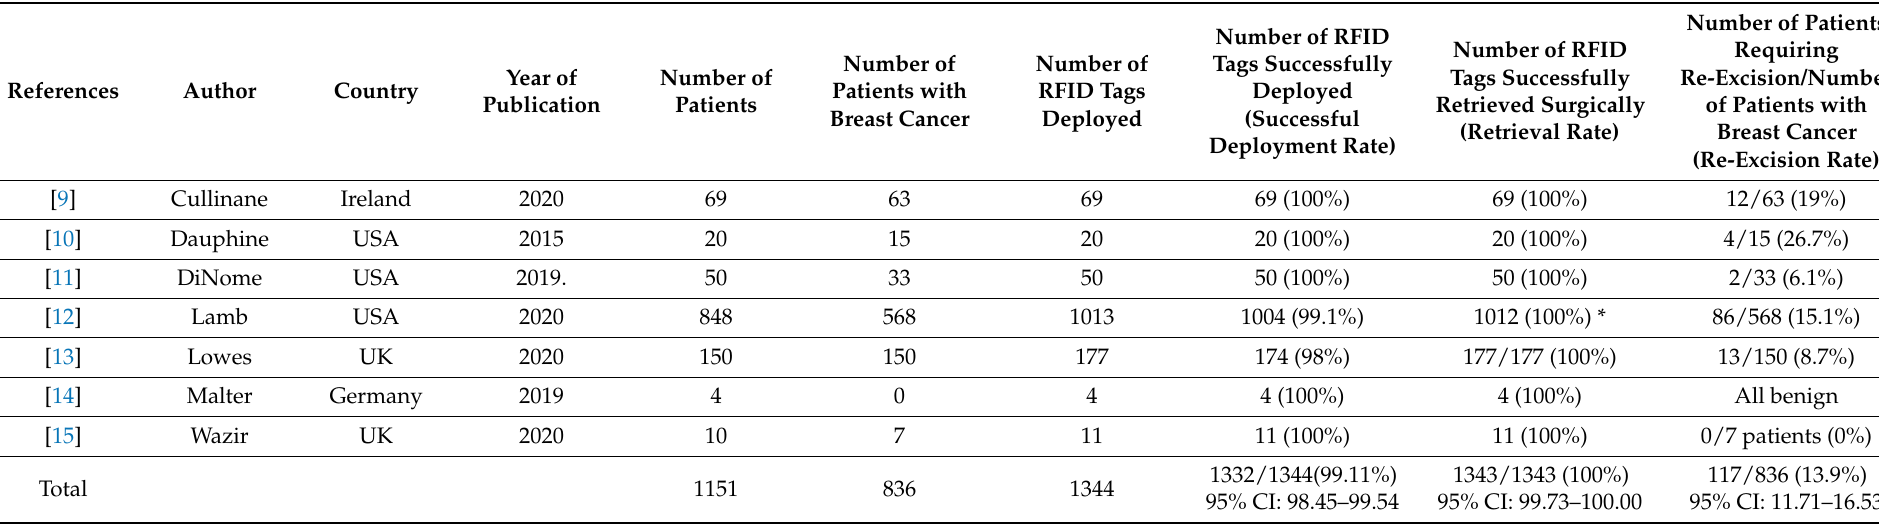
Table 1. Details of studies included in pooled analysis. CI: confidence intervals; RFID: radiofrequency identification.